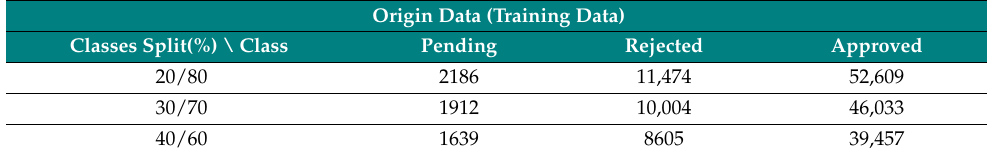
Table 2. Classes distribution of the original data